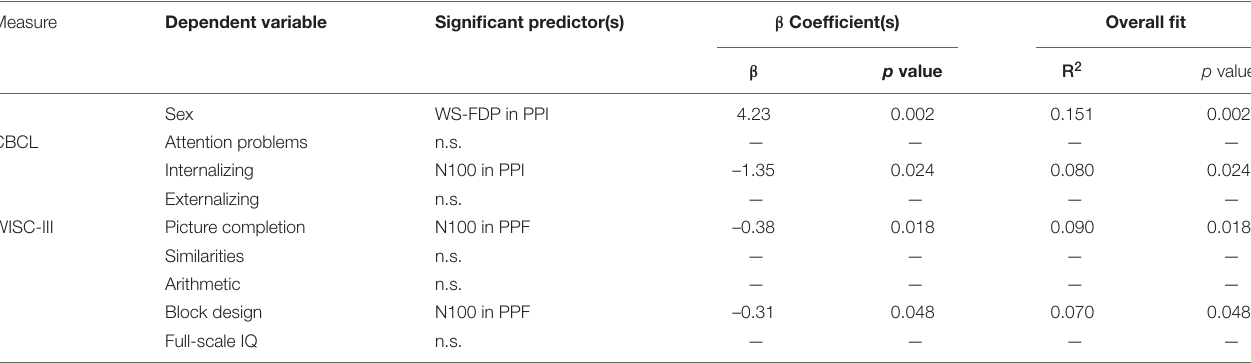
FIGURE 9 | Linear terms of ERP amplitudes in PPF correlating with age as scatterplots. (A) Age versus N100 in PPF (left) and age versus P200 in PPF (right) in the whole population. (B) Age versus N100 in PPF for males subgroup. (C) Age versus P200 in PPF for females subgroup. Color-shaded areas indicate the 95% confidence interval of the best-fitting line. TABLE 2 | Stepwise multiple linear models for predicting gender and WISC-III and CBCL